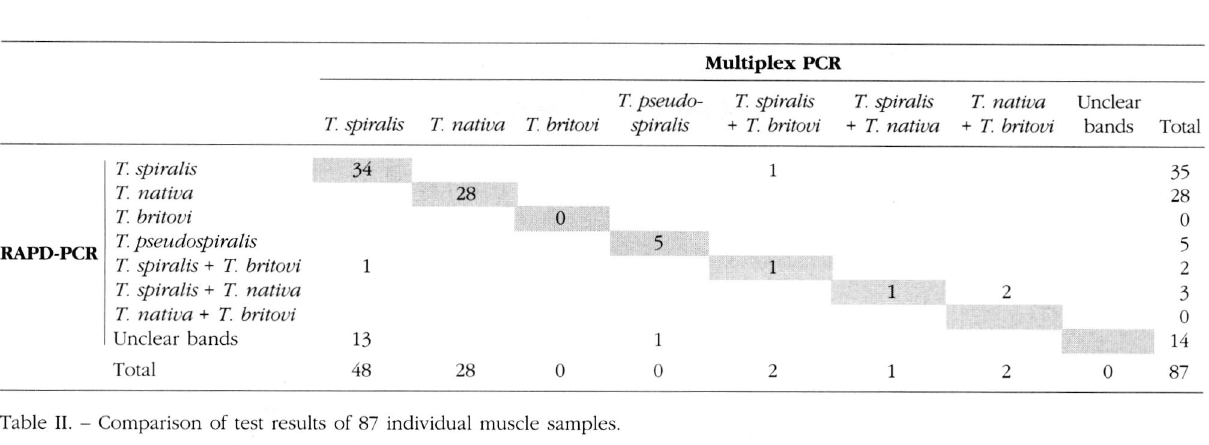
Table II. - Comparison of test results of 87 individual muscle samples.